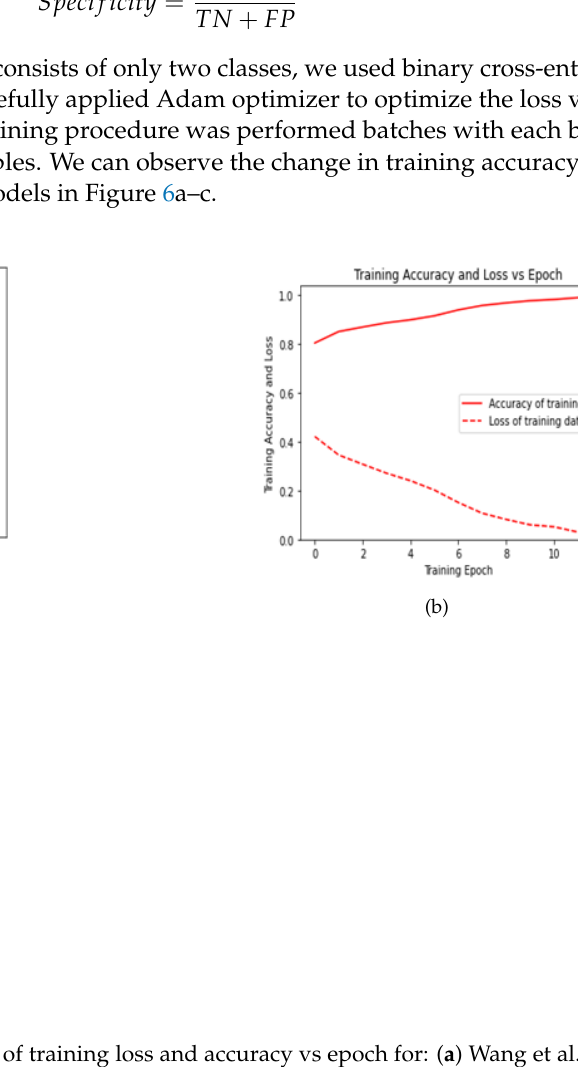
Figure 6. Graphical representation of training loss and accuracy vs epoch for: ( a ) Wang et al.’s [7] proposed CNN model, ( b ) Sharan et al.’s [8] proposed CNN model, ( c ) Almutairi et al.’s [10] proposed CNN-LSTM